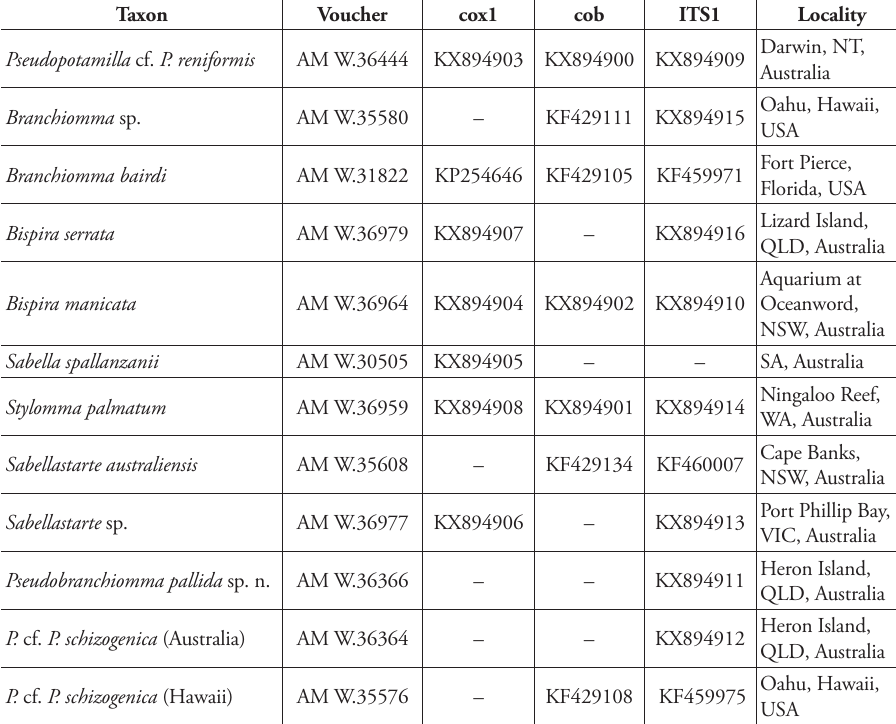
Table 4. Taxa and GenBank accession numbers for the genes sequenced for the present study. NSW, New South Wales; NT, Northern Territory, QLD; Queensland; SA, South Australia; WA, Western Australia. Taxon Voucher